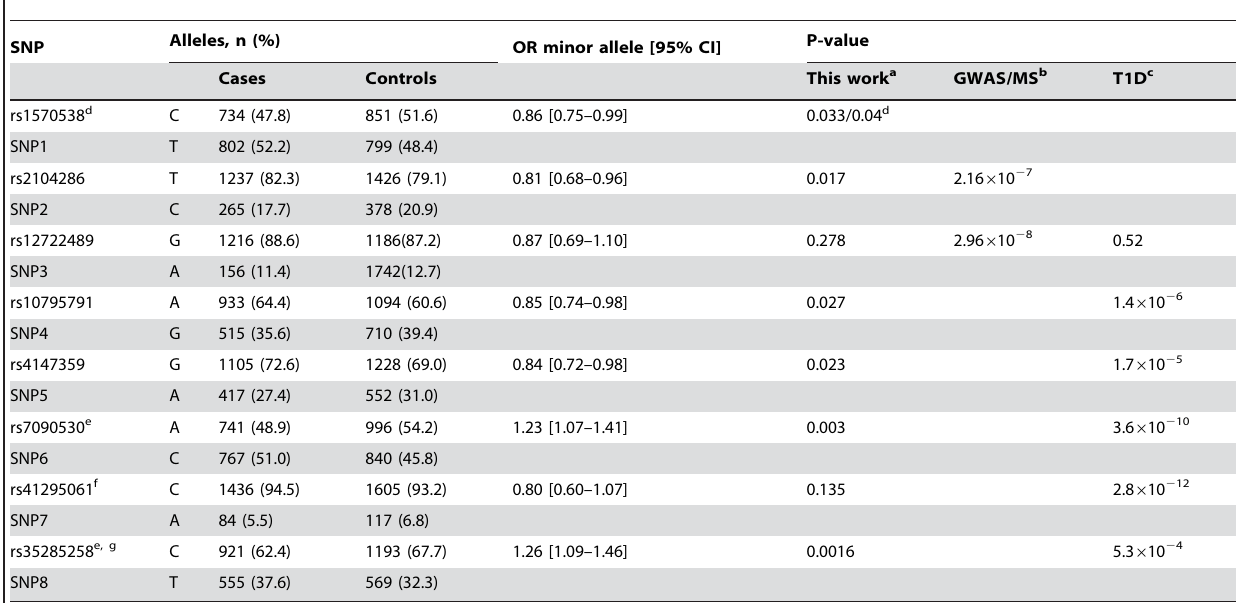
Table 1. Allele distribution and frequency of IL2RA SNPs in patients with multiple sclerosis and healthy controls.